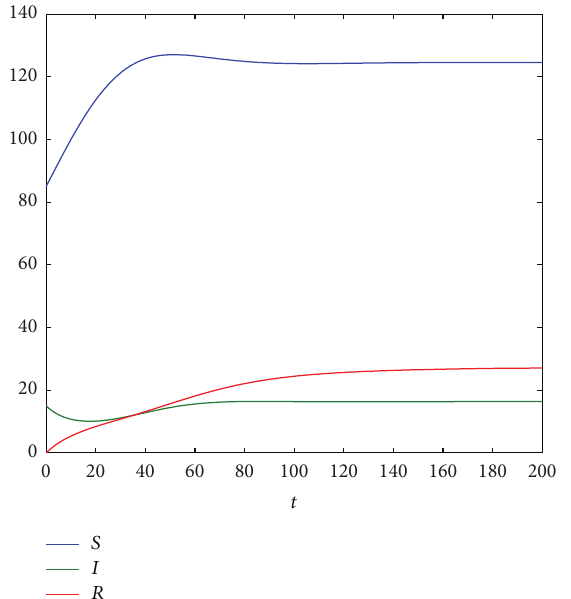
Figure 1: The global stability of the endemic equilibrium 𝐸 ∗ = (𝑆 ∗ , 𝐼 ∗ , 𝑅 ∗ ) for model (21) with initial values 𝑆(0) = 85 , 𝐼(0) = 15 , and 𝑅(0) = 0 . The parameters are taken as